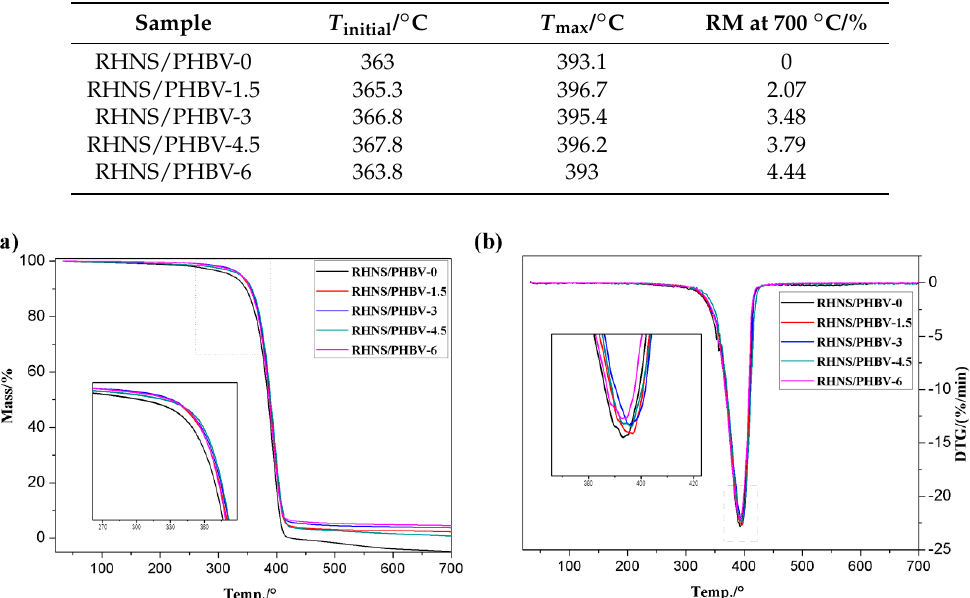
Table 2. Thermal analysis data of RHNS/PHBV composites derived from TGA curves.